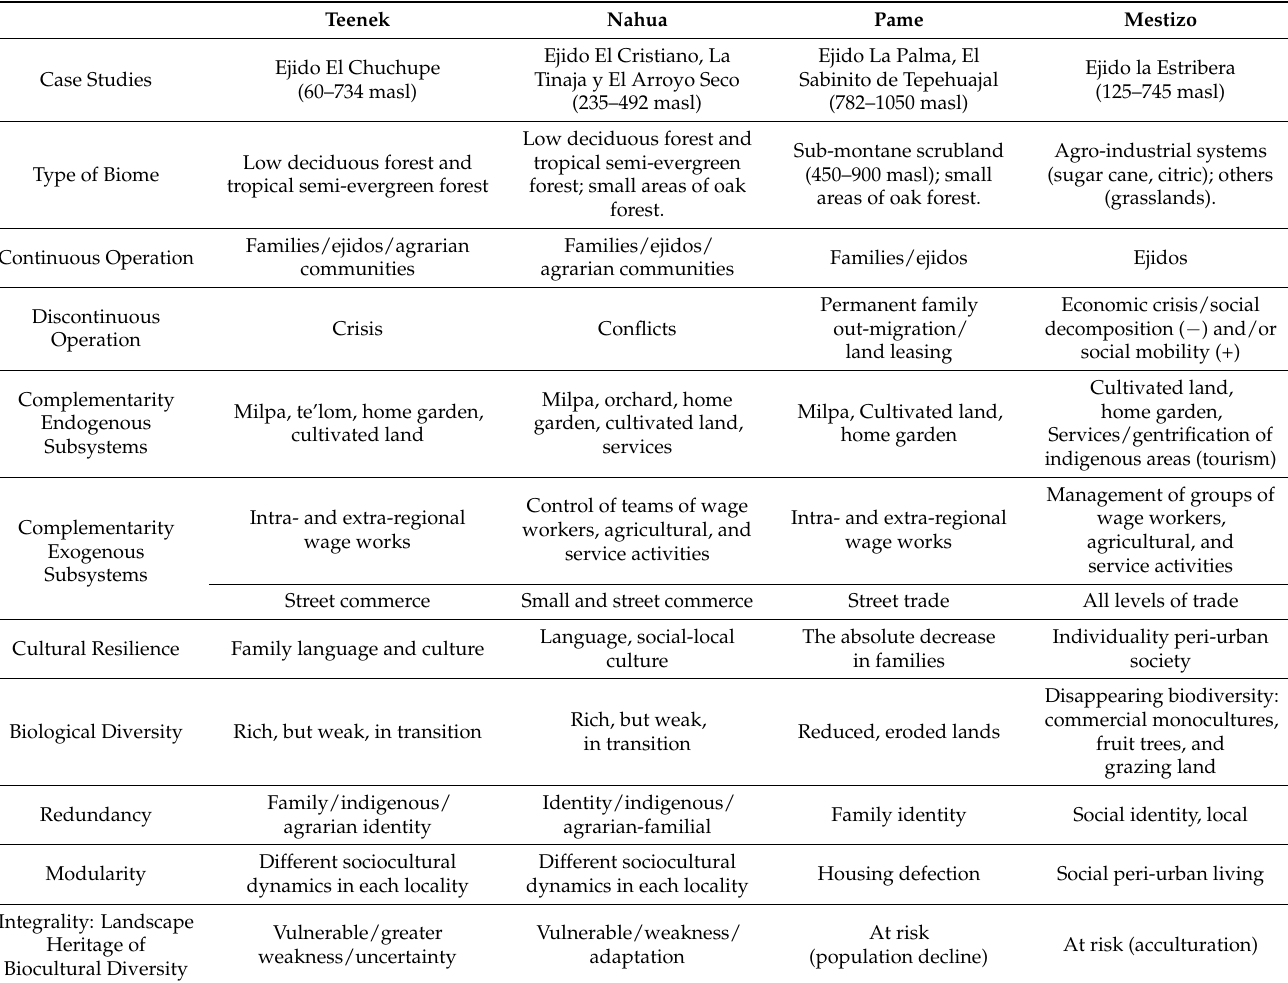
Table 1. Profiles of four SESs of Huasteca